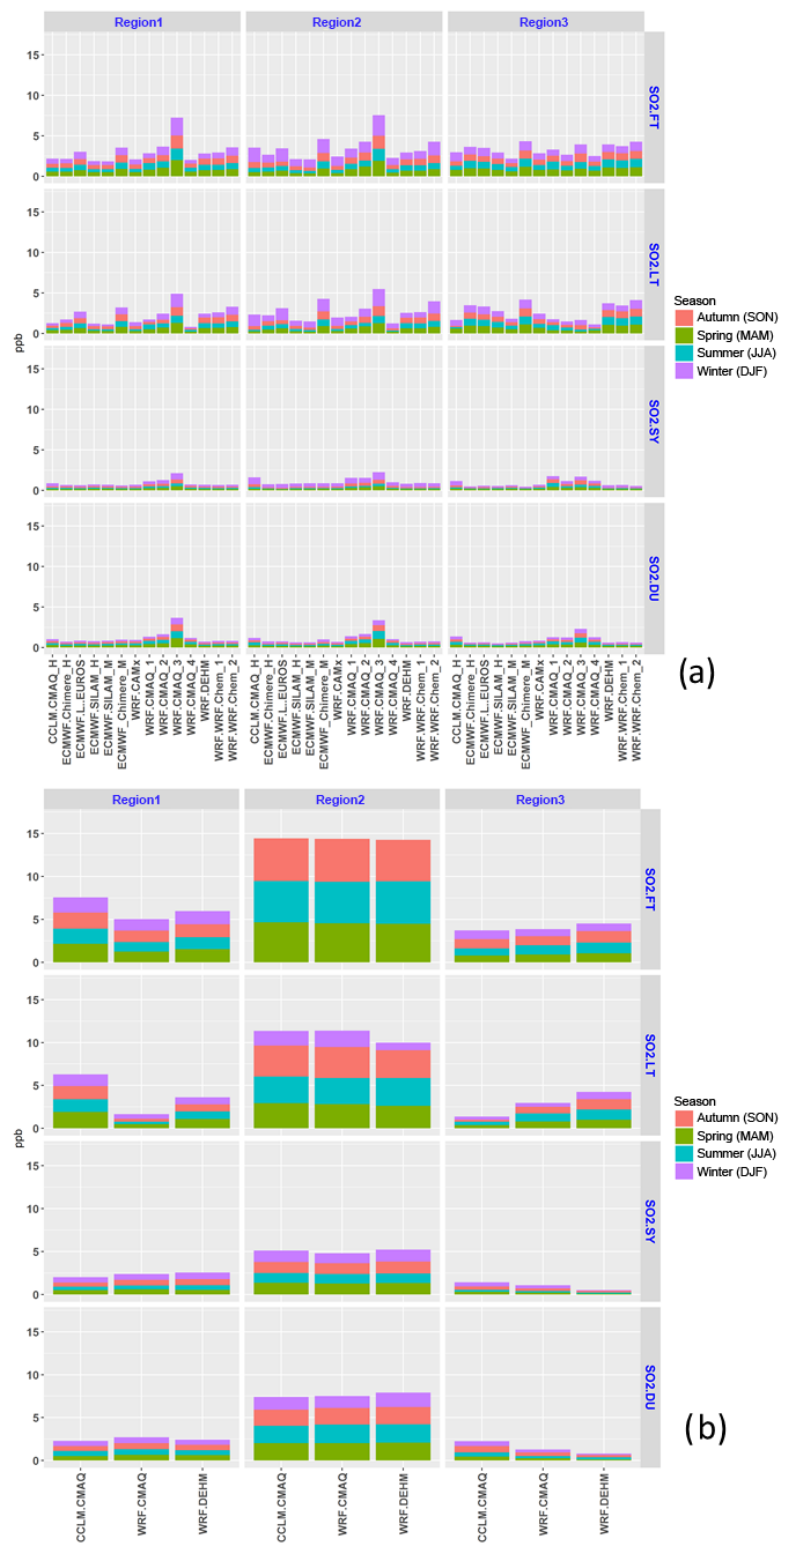
Figure 22. As in Fig. 9 but for SO 2